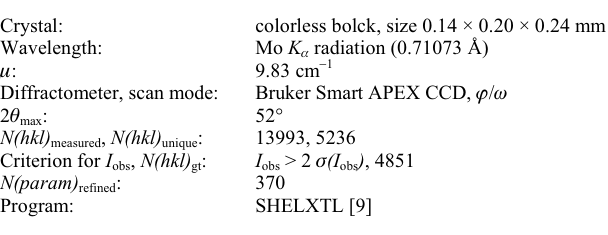
Table 1. Data collection and handling.